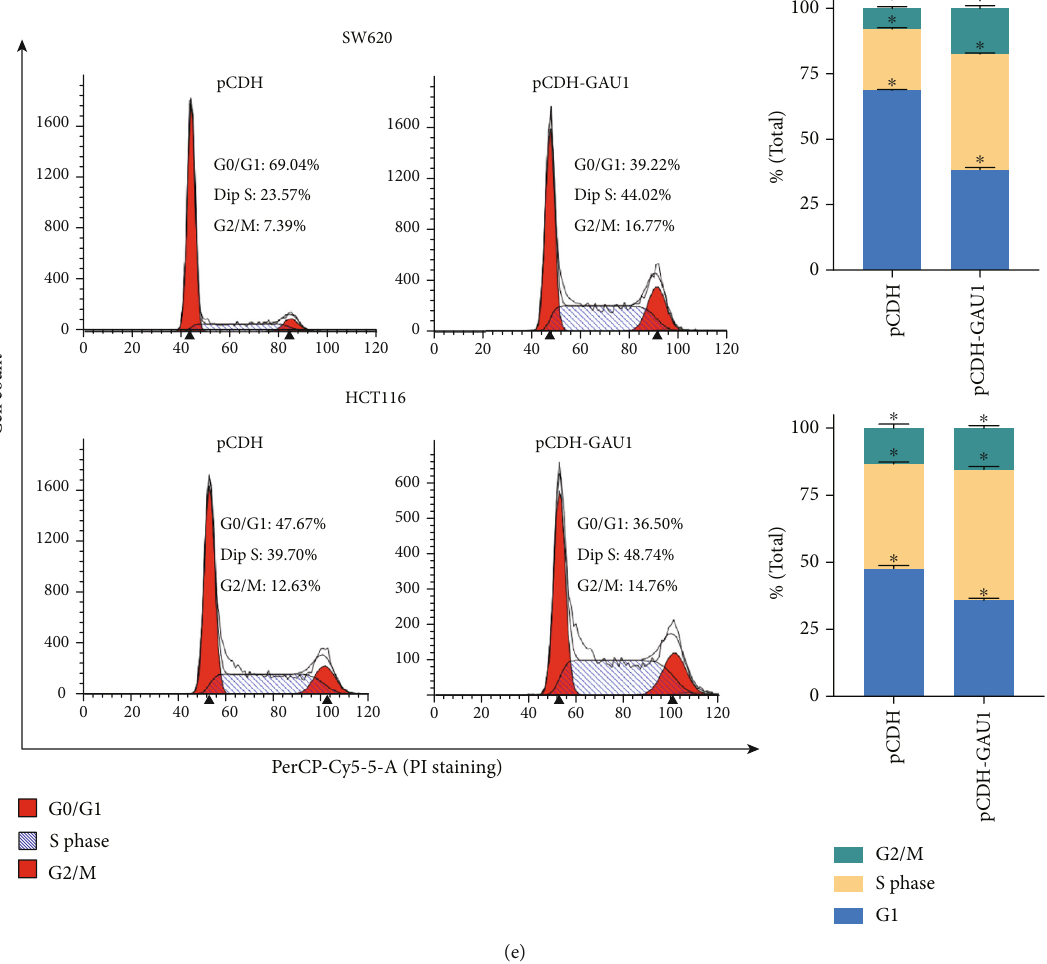
Figure 2: GAU1 overexpression facilitates CRC cell proliferation. (a) CCK-8 assay and (b) colony formation assay were conducted in SW620 and HCT116 cells transfected with GAU1 overexpression or control plasmids. ∗ P < 0 : 05 ; ∗∗ P < 0 : 01 . (c) CCK-8 assay and (d) colony formation assay showed the proliferation of control siRNA (siNS) or siRNAs (siGAU1-1 and siGAU1-2) against GAU1-transfected DLD1 and LoVo cells. ∗ P < 0 : 05 ; ∗∗ P < 0 : 01 . (e) Cell cycle analysis of GAU1-overexpressed HCT116, SW620, and their